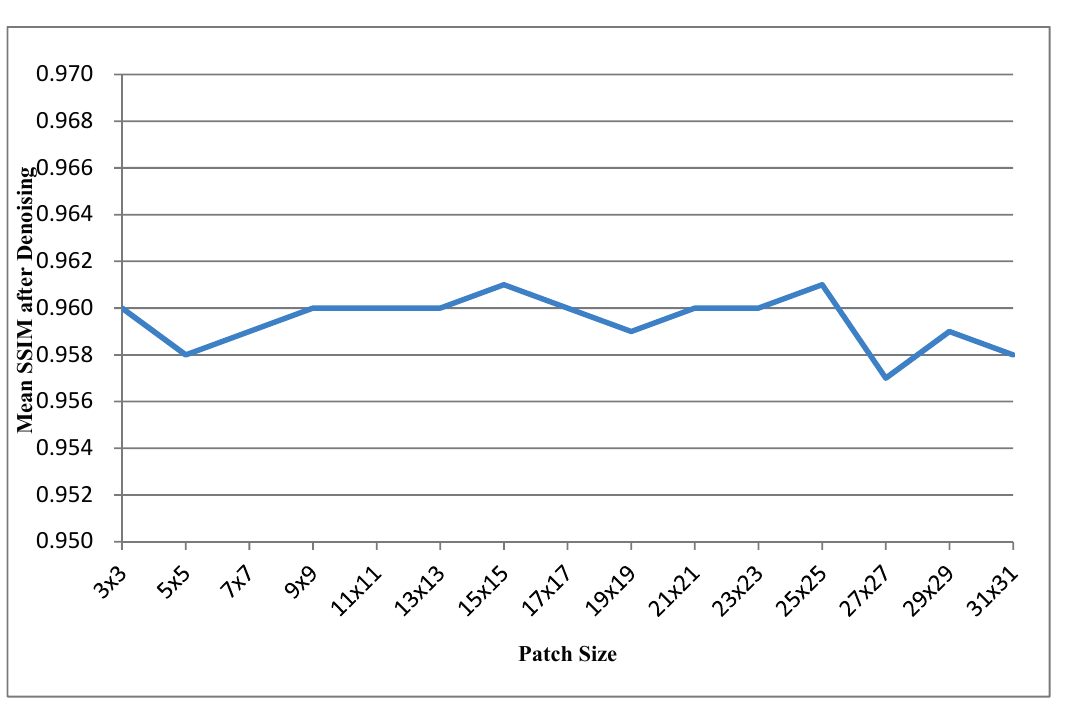
Figure 5. Curve of average of mean PSNR Improvements vs. patch size.